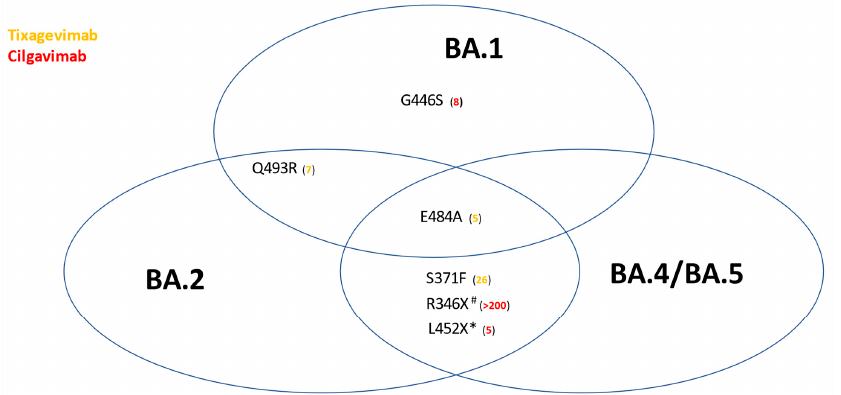
Figure 1. Impact of selected Spike protein mutations on the in vitro efficacy of Evusheld™. Numbers in parentheses represent fold-reductions in the geometric mean titer of neutralizing antibody titers. Only mutations for which the majority of studies are concordant are reported. Sourced from https:// covdb.stanford.edu/page/susceptibility-data/ (accessed on 2 September 2022). * L452R is universal among BA.4/5, but occurs only in BA.2.11, BA.2.35, BA.2.75.4, BA.2.77, while L452Q occurs only in BA.2.12.1. # R346I in BA.5.9, R346S in BA.4.7 and BF.13, R346T in BA.1.23, BA.2.9.4, BA.2.80, BA.2.82, BA.4.1.8, BA.4.6, BF.7 and BF.11.